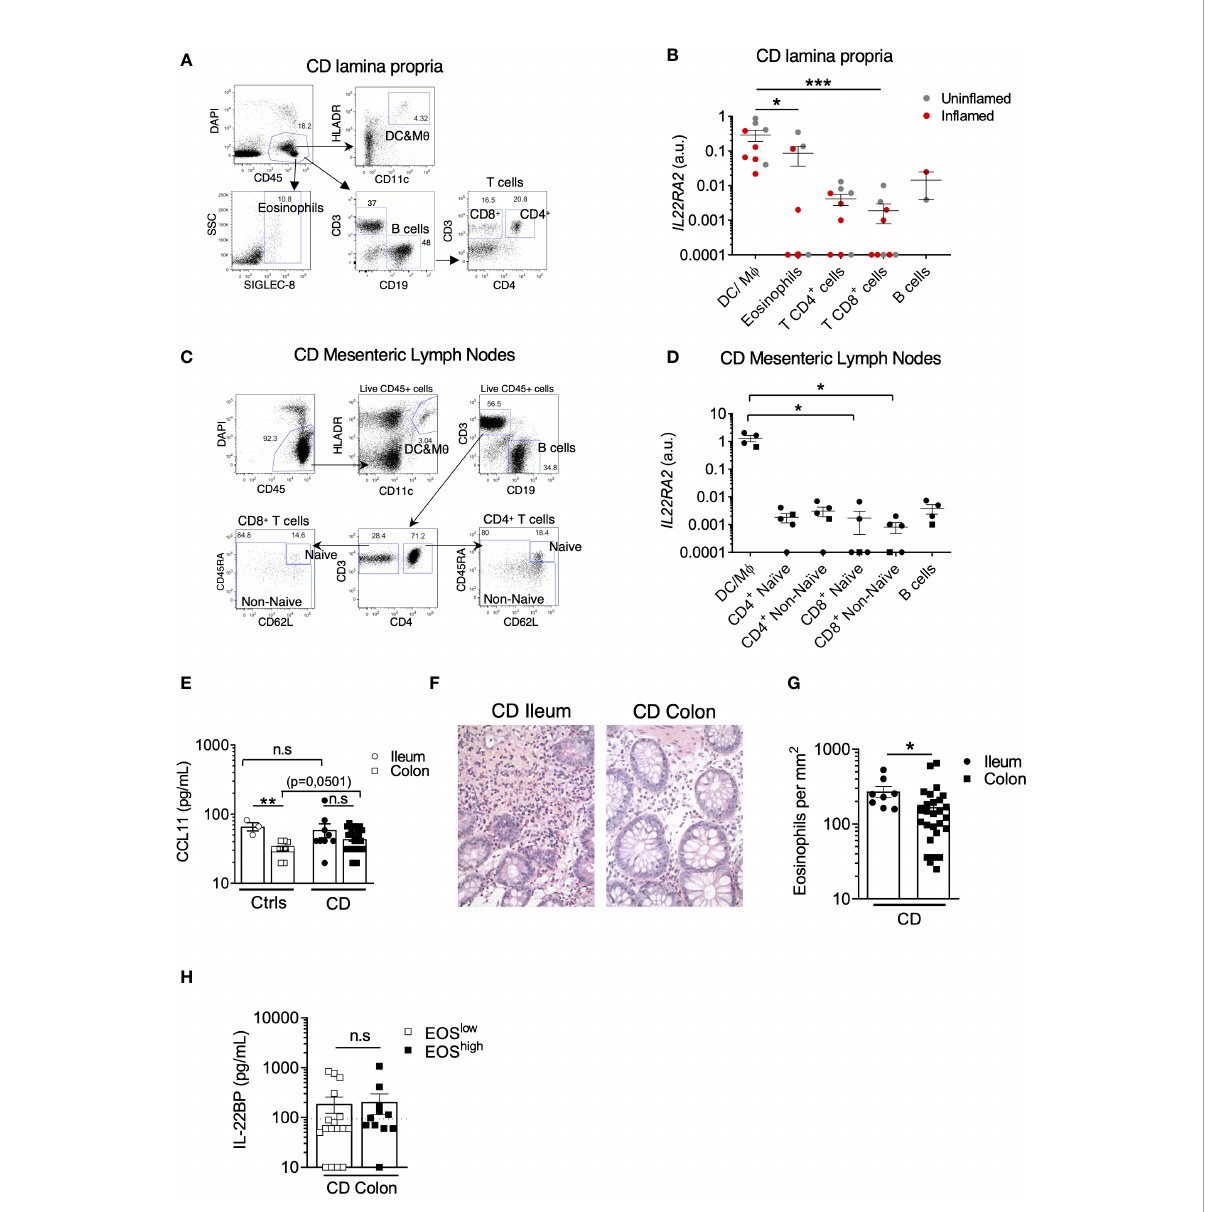
FIGURE 2 The highest levels of IL22BP expression are detected in CD MNP and eosinophils. (A) Representative dot plots of the gating strategy used to sort indicated cell subsets from the lamina propria (LP) of intestinal surgical resections from Crohn ’ s disease (CD) patients. (B) IL22RA2 expression was analyzed by RT-qPCR in indicated FACS-sorted cell subsets from CD patient gut LP samples (n=6). Grey and red dots refer to cells sorted from surgical resections respectively de fi ned as non-in fl amed and in fl amed after pathology examination. (C) Representative dot plots of the gating strategy used to sort indicated cell subsets from mesenteric lymph nodes (MLN) of CD patients. (D) IL22RA2 expression was analyzed by RT-qPCR in indicated FACS-sorted cell subsets from CD patient MLNs (n=5) with in fl amed ileum (circles) or colon (square). (E) Levels of soluble CCL11 were quanti fi ed in gut endoscopic biopsy supernatants from controls (Ctrls) (n=12) and CD (n=37) patients after 6 hours of ex vivo culture. Dots and squares refer to ileum and colon tissues respectively. (F) Representative pictures of slides from formalin- fi xed, paraf fi n-embedded (FFPE) sections of CD tissues stained with standard hematoxylin and eosin (HES) coloration. Original magni fi cation x 200. (G) Eosinophil counts were scored in a blinded manner by a trained pathologist on HES slides from CD patients (n=36). Each count was obtained by averaging the results obtained from the analysis of 5 different fi elds and was expressed as eosinophils per mm 2 . (H) Comparison of soluble IL-22BP levels in the supernatant of endoscopic colonic biopsies of CD patients strati fi ed into eosinophils (EOS) high and EOS low based on the median value. Mean comparisons of unpaired samples were performed using the Kruskal Wallis (for > 2 conditions) or the Mann-Whitney U-test. P-value < 0.05 were considered statistically signi fi cant. *P < 0.05, **P < 0.01, ***P < 0.001 ns, not signi fi